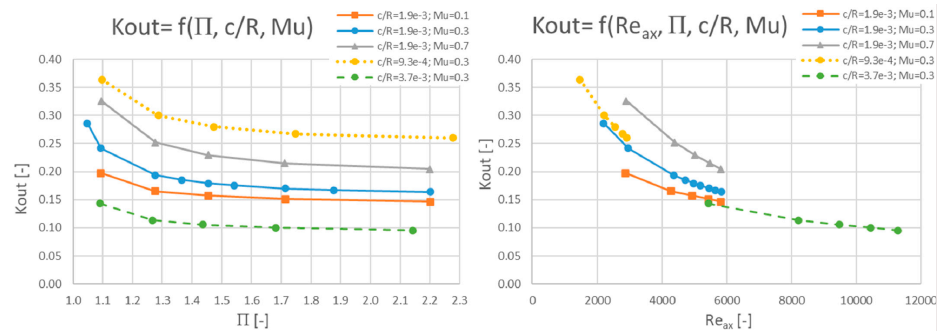
Figure 5. Exit swirl ratio dependency on π , Re ax , c / R , and M u